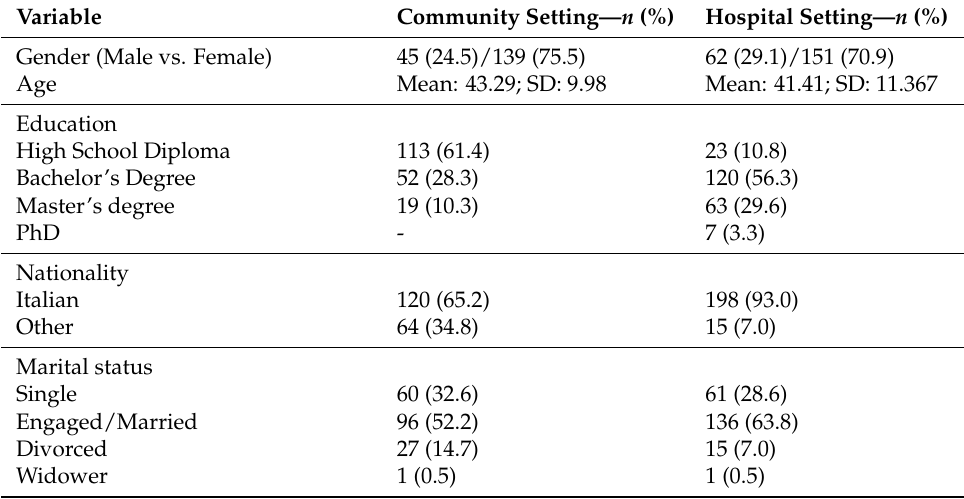
Table 1. Demographics and professional characteristics of the